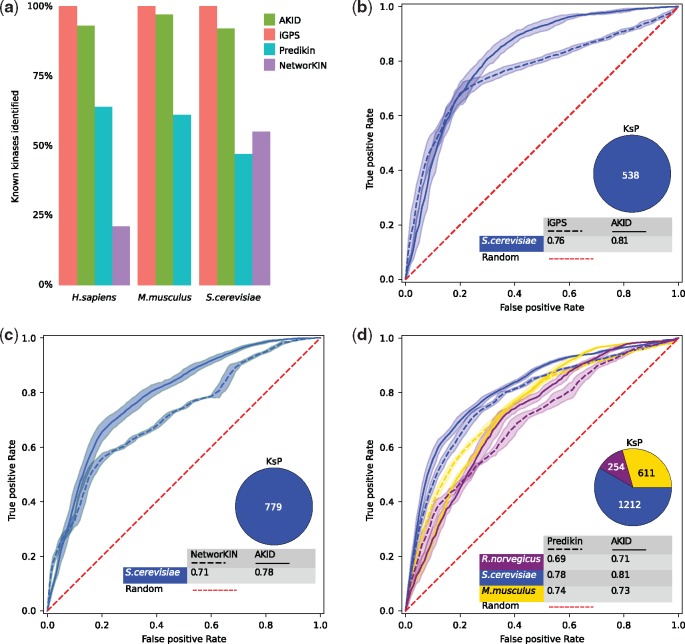
Comparison between AKID and other published methods. a: Coverage of known kinases (collected from KinBase) identified by different methods in three different organisms with the highest amount of known KsP. b–d: ROC curves, with AUC values, representing the comparison between AKID (continuous ROC curves) and the other methods (dashed ROC curves) in different organisms (ROC curves with different colors)